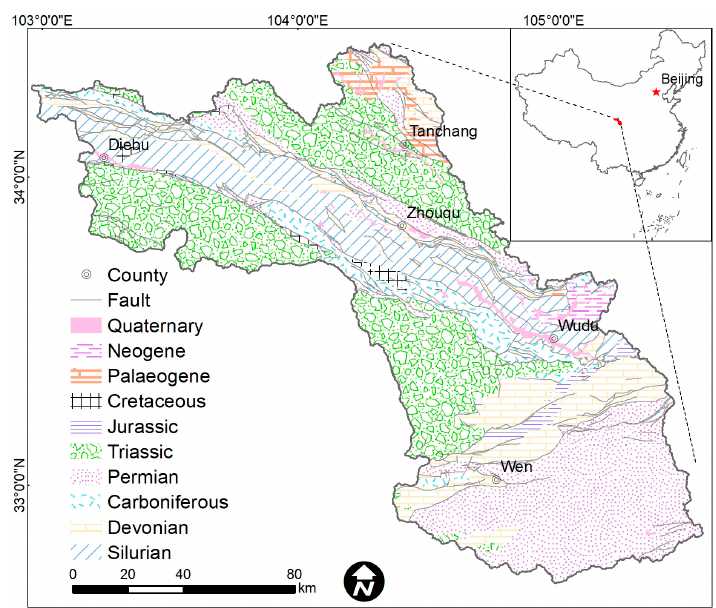
Figure 1. Geology and debris flow distribution in the Bailong River Basin.